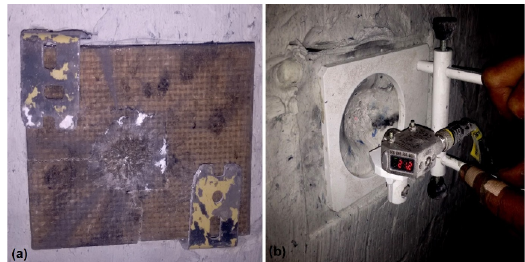
Figure 4. (a) Indentation depth in the clay witness caused by the bullet impact on MAS after ballistic impact. (b) Measurement with Laser sensor caliper, model Q4X by Banner manufacturer.